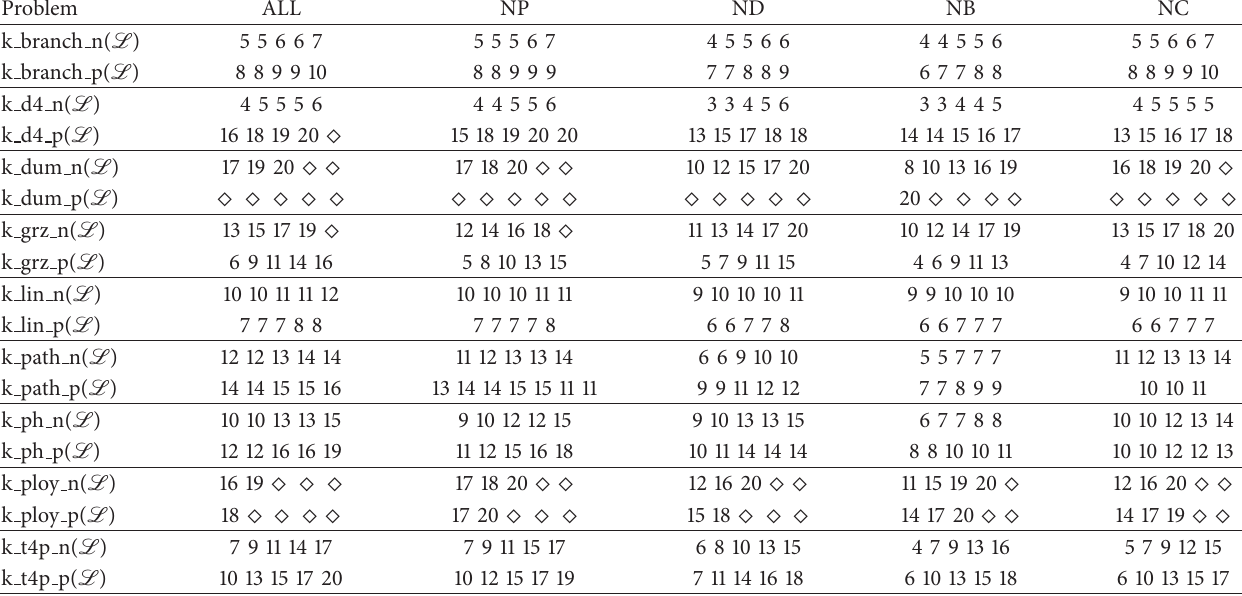
Table 7: Results for K( L ) TBox